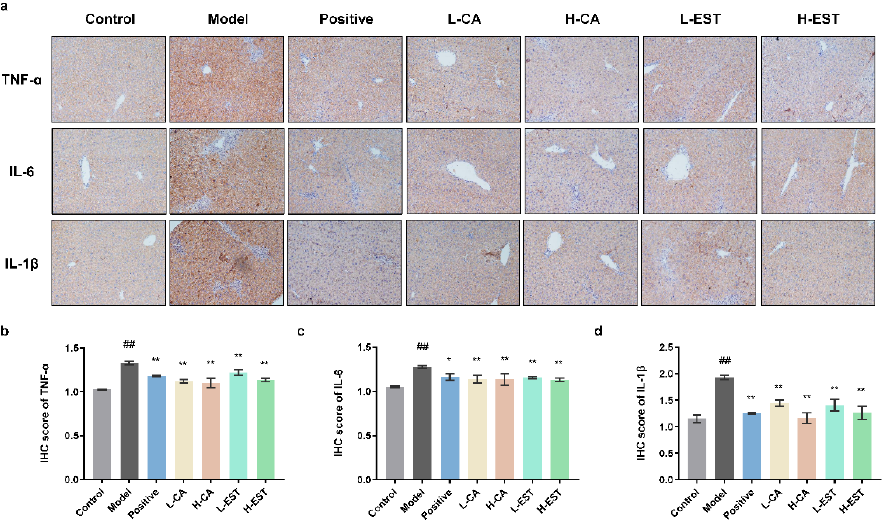
Figure 5. Effects of EST and CA on liver TNF- α , IL-6, and IL-1 β expression. ( a ) Immunohistochemical staining of gastric TNF- α , IL-6, and IL-1 β . ( b – d ) Densitometric quantification ( n = 3). Data are expressed as mean ± SD. ## p < 0.01 compared with the control group; * p < 0.05, ** p < 0.01 compared with the model group.